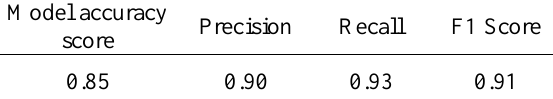
Table 5. Model prediction